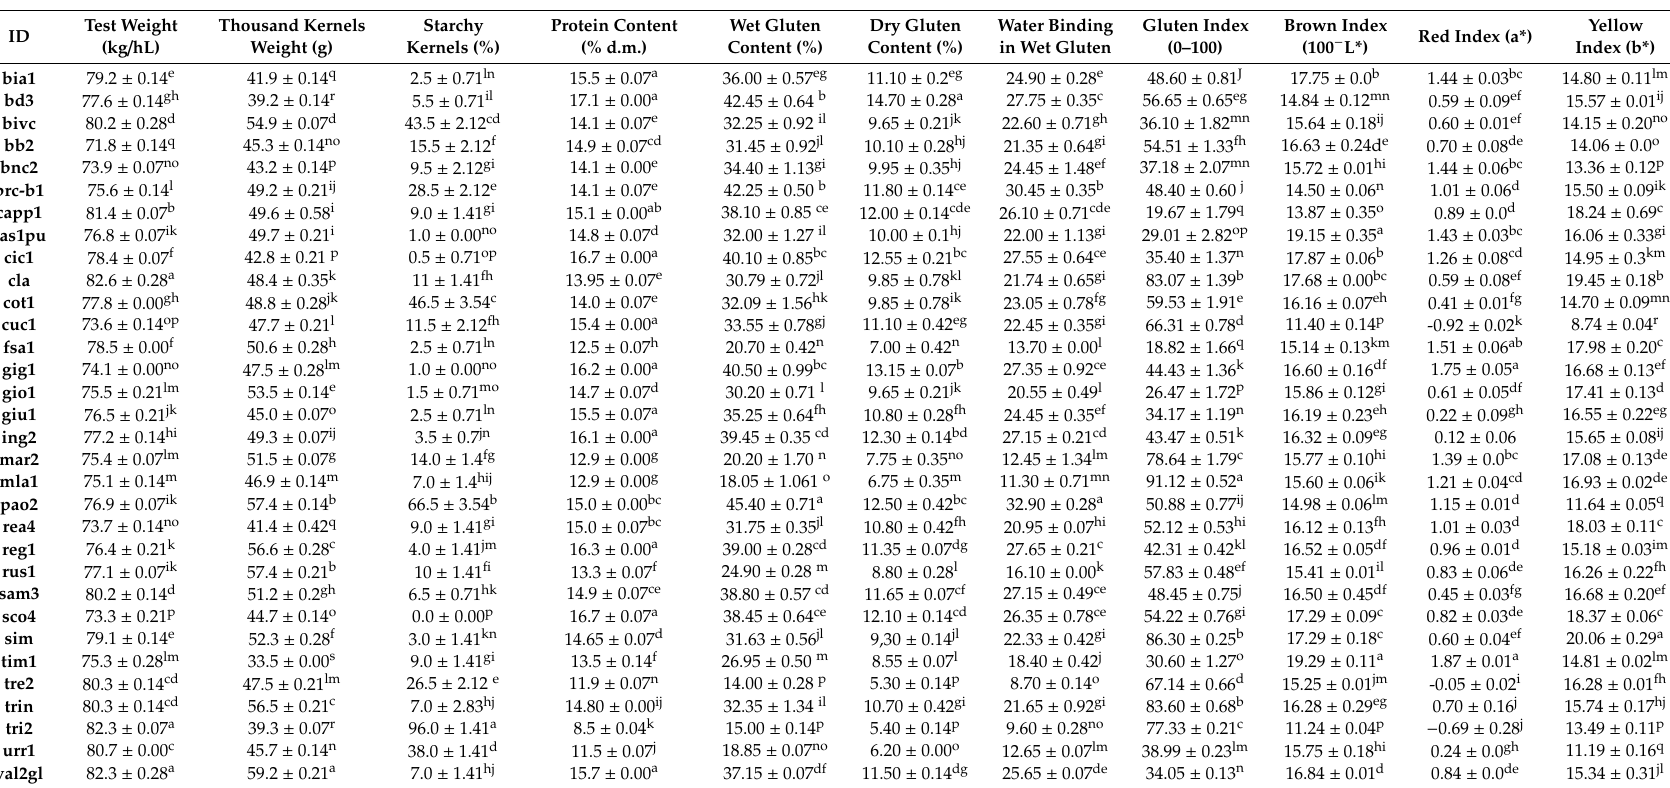
Table 1. Means comparison and post hoc test (Tukey’s) for grain and wholemeal flour quality-related parameters of Sicilian wheat germplasm